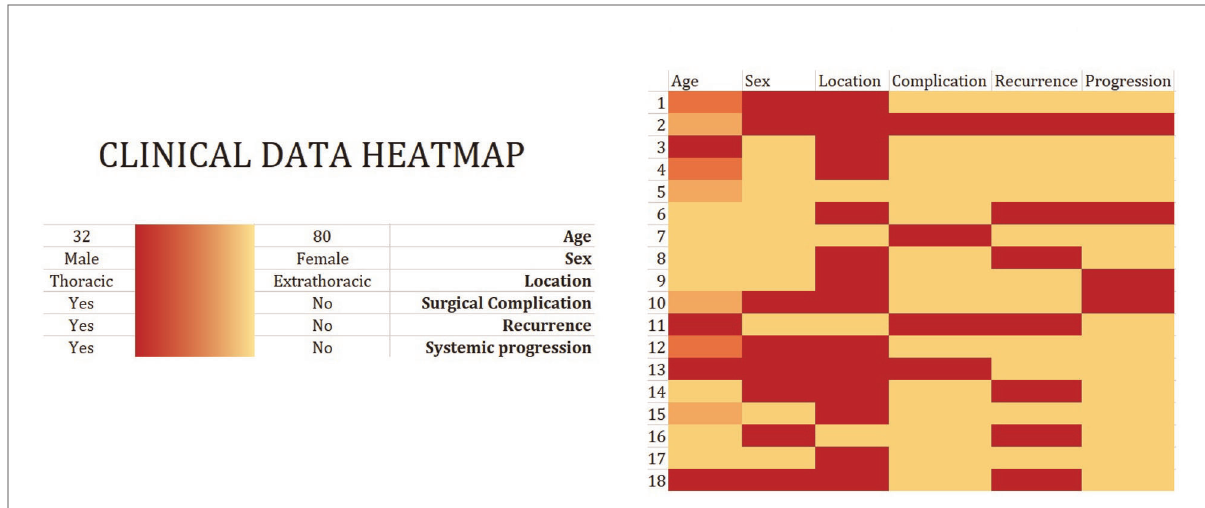
FIGURE 3 Clinical data heatmap. Eighteen patients underwent surgical treatment between April 2014 and December 2021 for the diagnosis of solitary fi brous tumor (SFT). Clinical data, including age, sex, tumor location, and disease recurrence/systemic progression, are visualized in a heatmap. The color intensity shows the magnitude of a selected phenomenon.